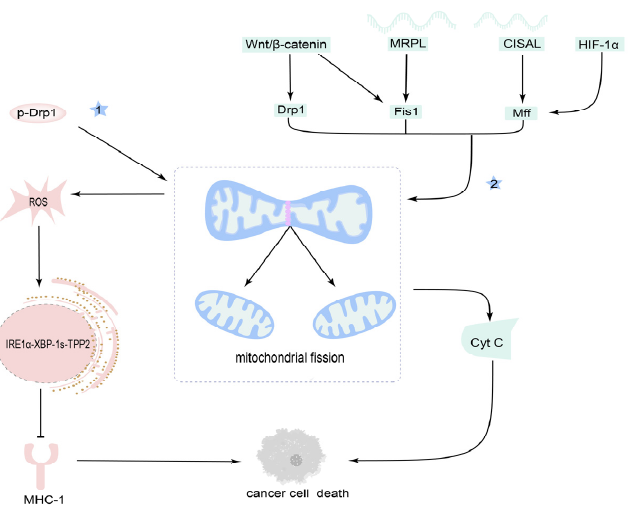
Figure 4. Targeting mitochondrial fission for OSCC therapy. (1) Inhibition of mitochondrial fission can cause cancer cell death by the upregulation of the major histocompatibility complex-I (MHC-I) in cancer cells. (2) Activation of mitochondrial fission can cause cancer cell death by the release of Cyt C from mitochondria.